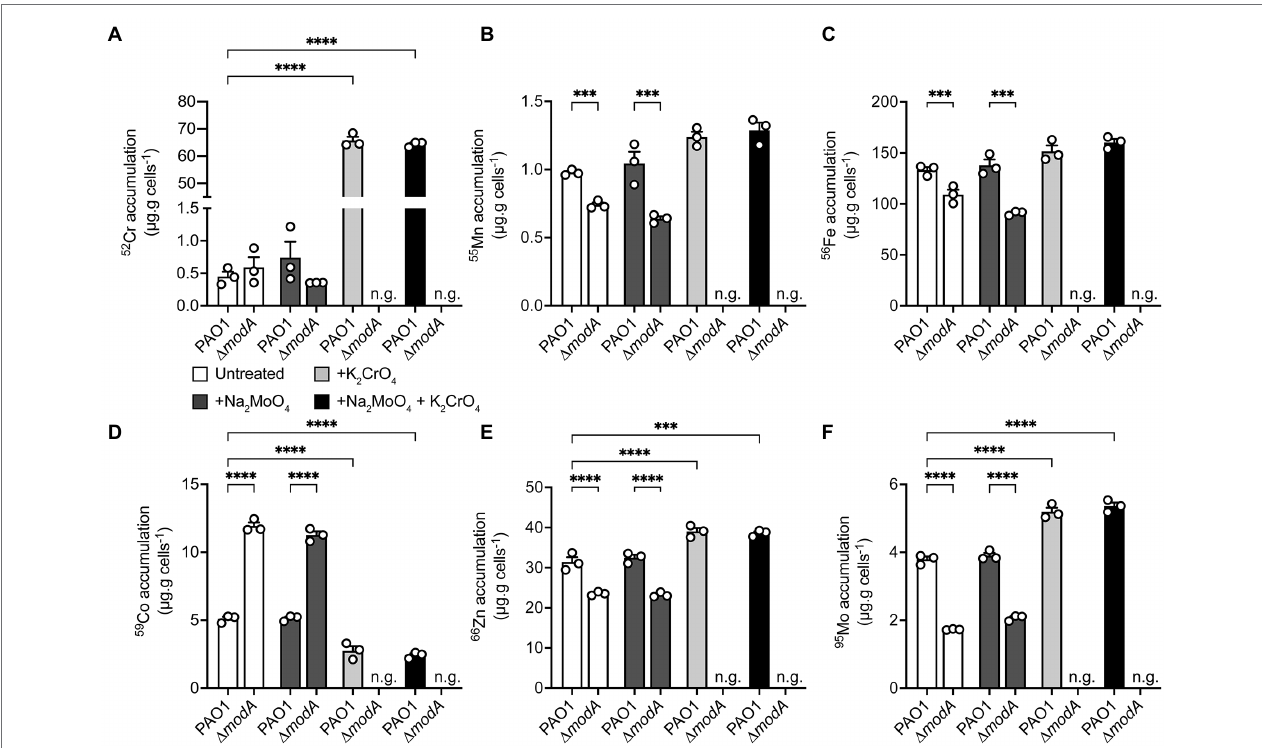
FIGURE 7 | Modulations in cellular metal ion content under anaerobic conditions in response to chromate and molybdate exposure. Whole cell accumulation of (A) chromium, (B) manganese, (C) iron, (D) , cobalt, (E) zinc, and (F) molybdenum in the P. aeruginosa PAO1 wild-type and ∆ modA strains grown anaerobically in untreated M-CDM media or media supplemented with 32 μ M Na 2 MoO 4 and/or K 2 CrO 4 . Media conditions where no bacterial growth was observed, denoted by n.g., are indicated. Data represents the mean (±SEM) of three independent experiments. Statistical significance of the differences was determined by two-way ANOVA with Sidak post-test, *** = p < 0.001 and **** = p <